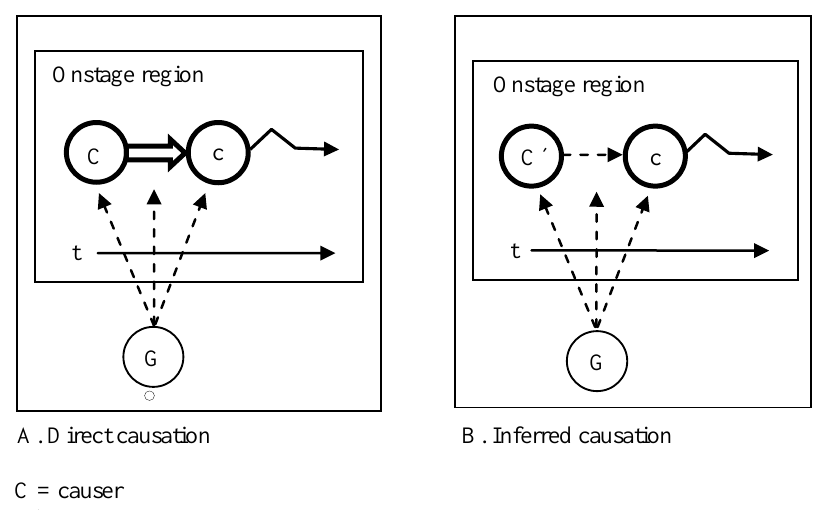
Figure 6. Inferred causation and